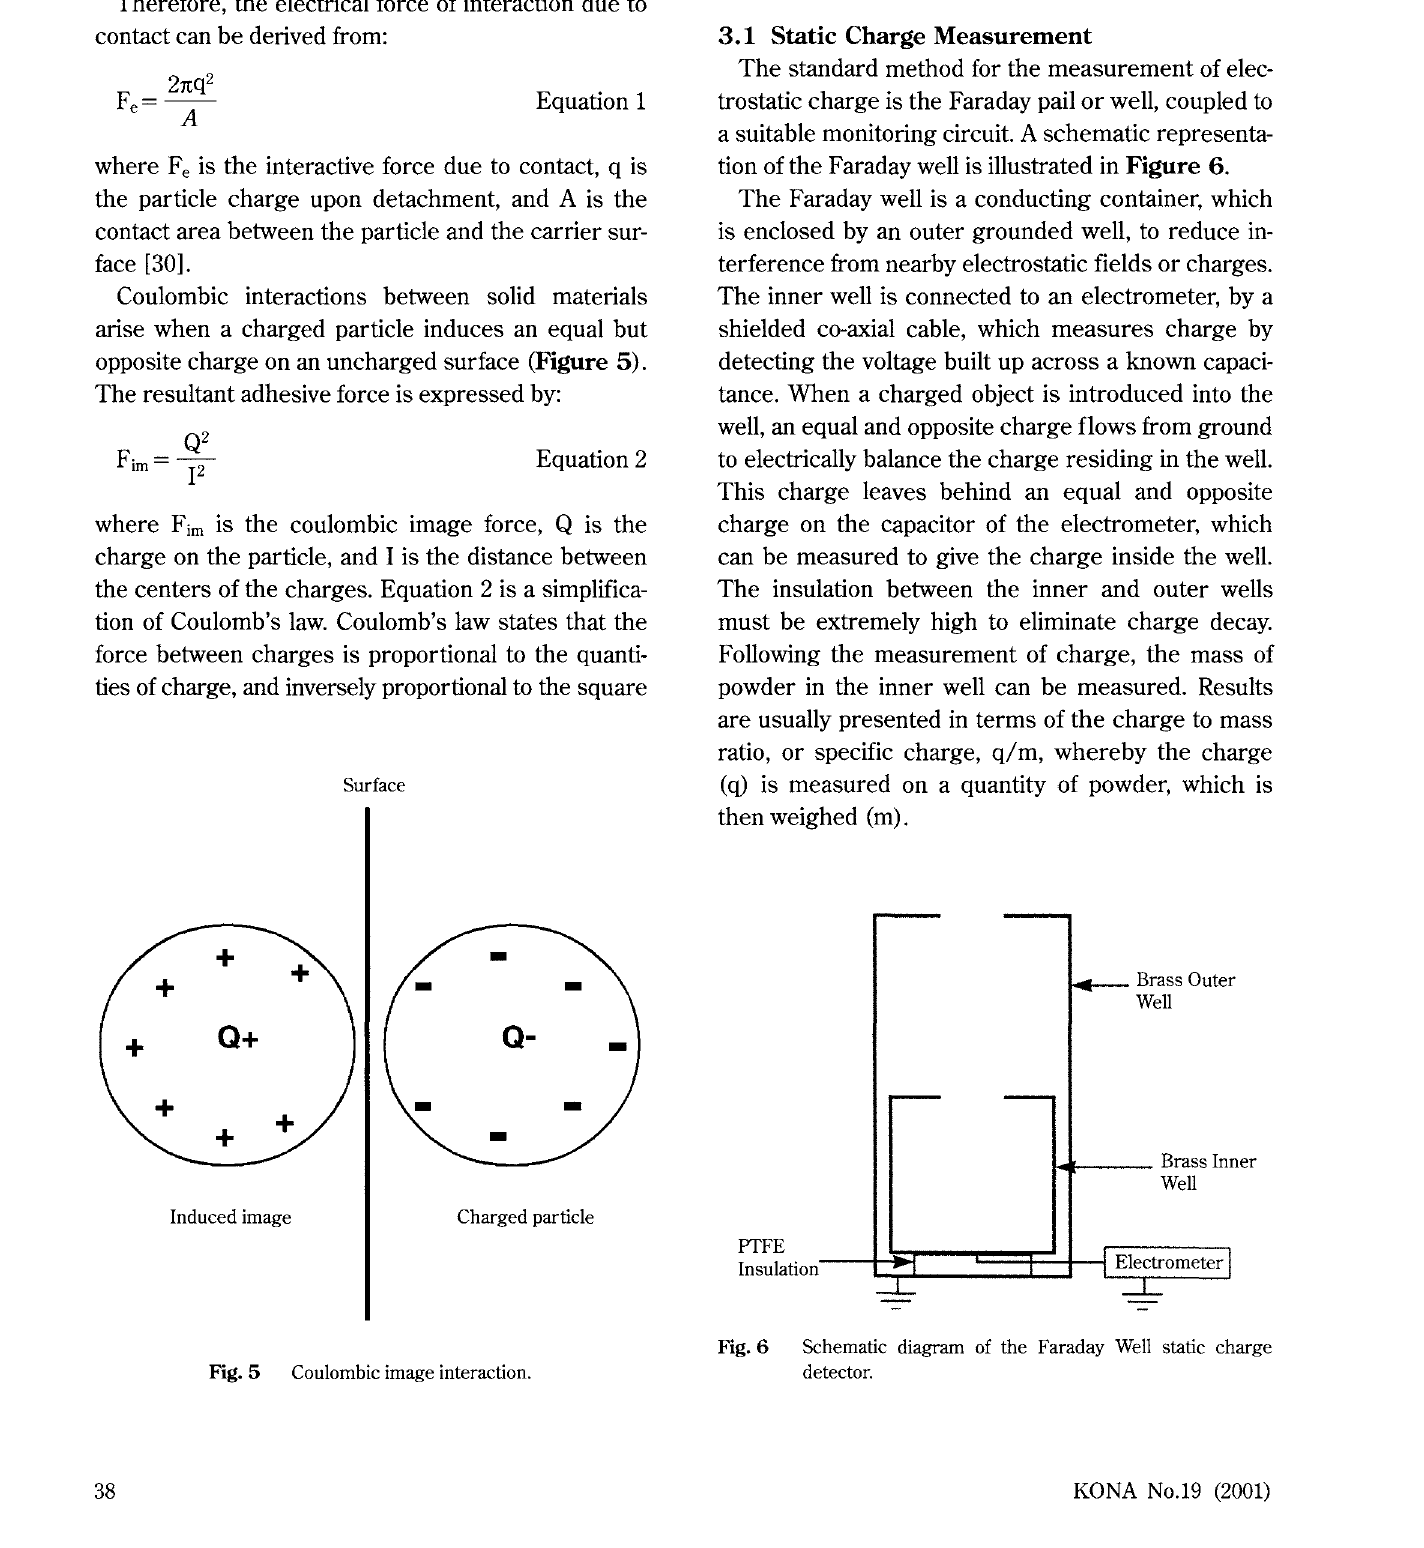
Schematic diagram of the Faraday Well static charge